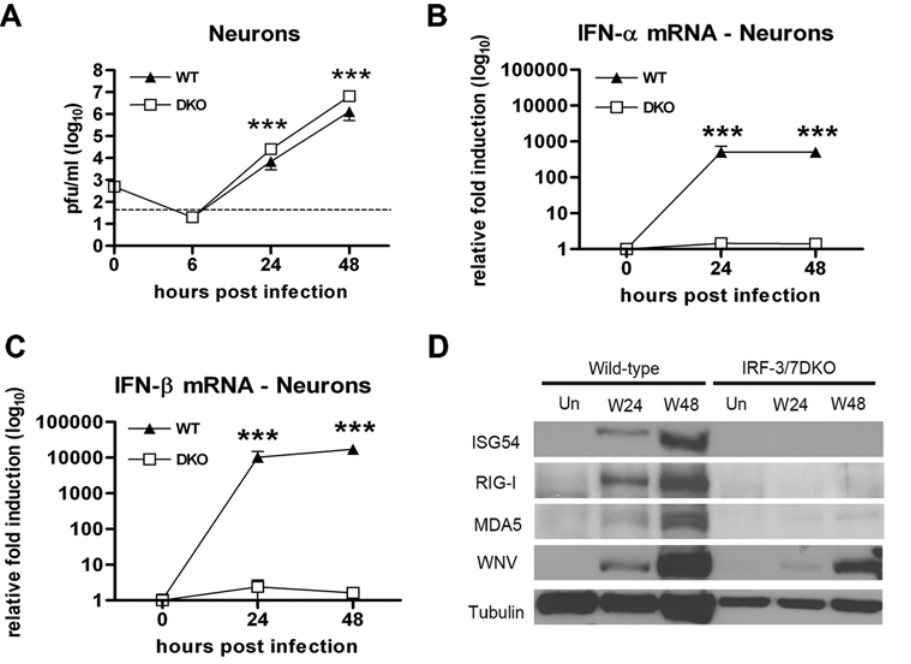
Figure 4. IRF-3 and IRF-7 restrict WNV infection by regulating the IFN- a / b response and ISG expression in primary cortical neurons. A . Primary cortical neurons generated from wild type or DKO mice were infected at an MOI of 0.001 and virus production was evaluated at the indicated times by plaque assay. Values are an average of triplicate samples generated from three independent experiments. Asterisks indicate values that are statistically significant (***, P , 0.0001). B and C . Levels of ( B ) IFN- a and ( C ) IFN- b mRNA in WNV-infected cortical neurons were measured by qRT-PCR as described in the legend of Figure 3. D . Whole cell lysates were generated at the indicated times from wild type or DKO MEF that were uninfected (Un) or infected with WNV (W). Protein levels of ISG54, RIG-I, and MDA5 were examined by immunoblot analysis. The data is the average of at least three independent experiments performed in quadruplicate (***, P , 0.0001).